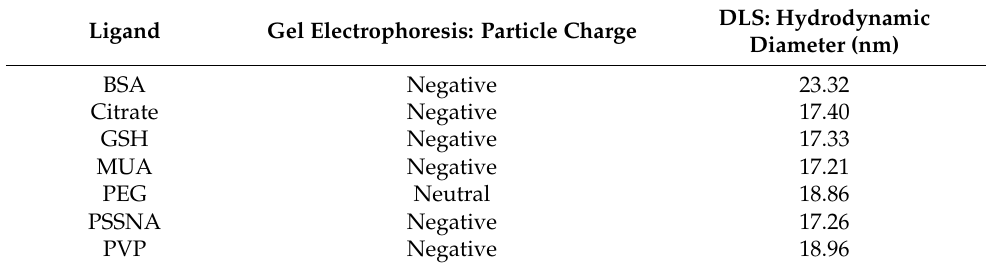
Table 1. Summary of the GNP-ligand characteristics.